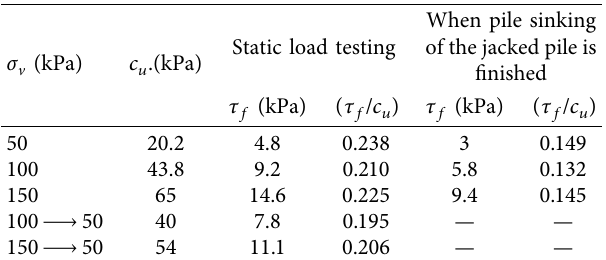
Table 3: Ratio of ultimate friction resistance to the undrained shear strength of the soil.